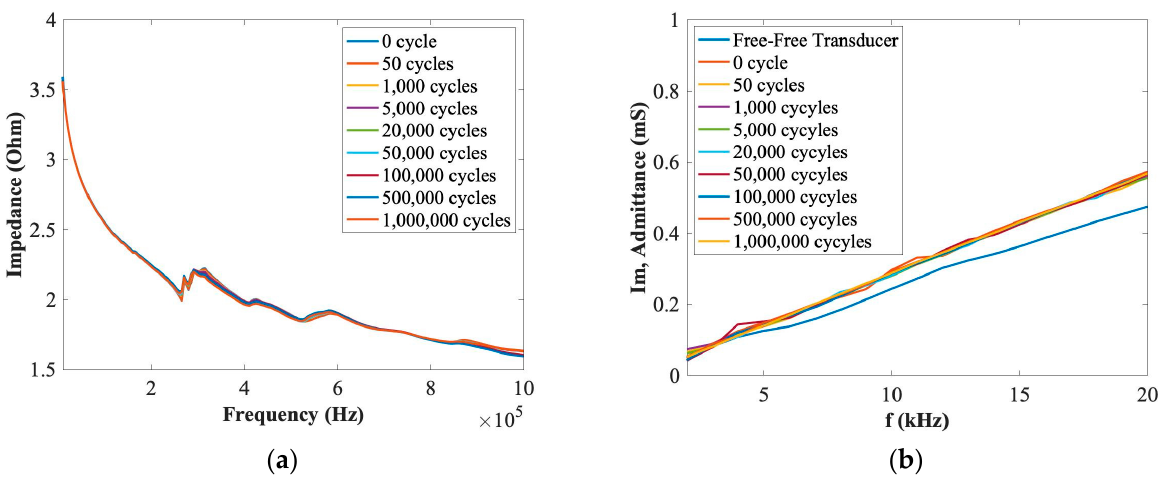
Figure 6. EMI properties of ( a ) impedance and ( b ) the imaginary part of admittance for the embedded PZT transducer under the force range of 1~10 kN.